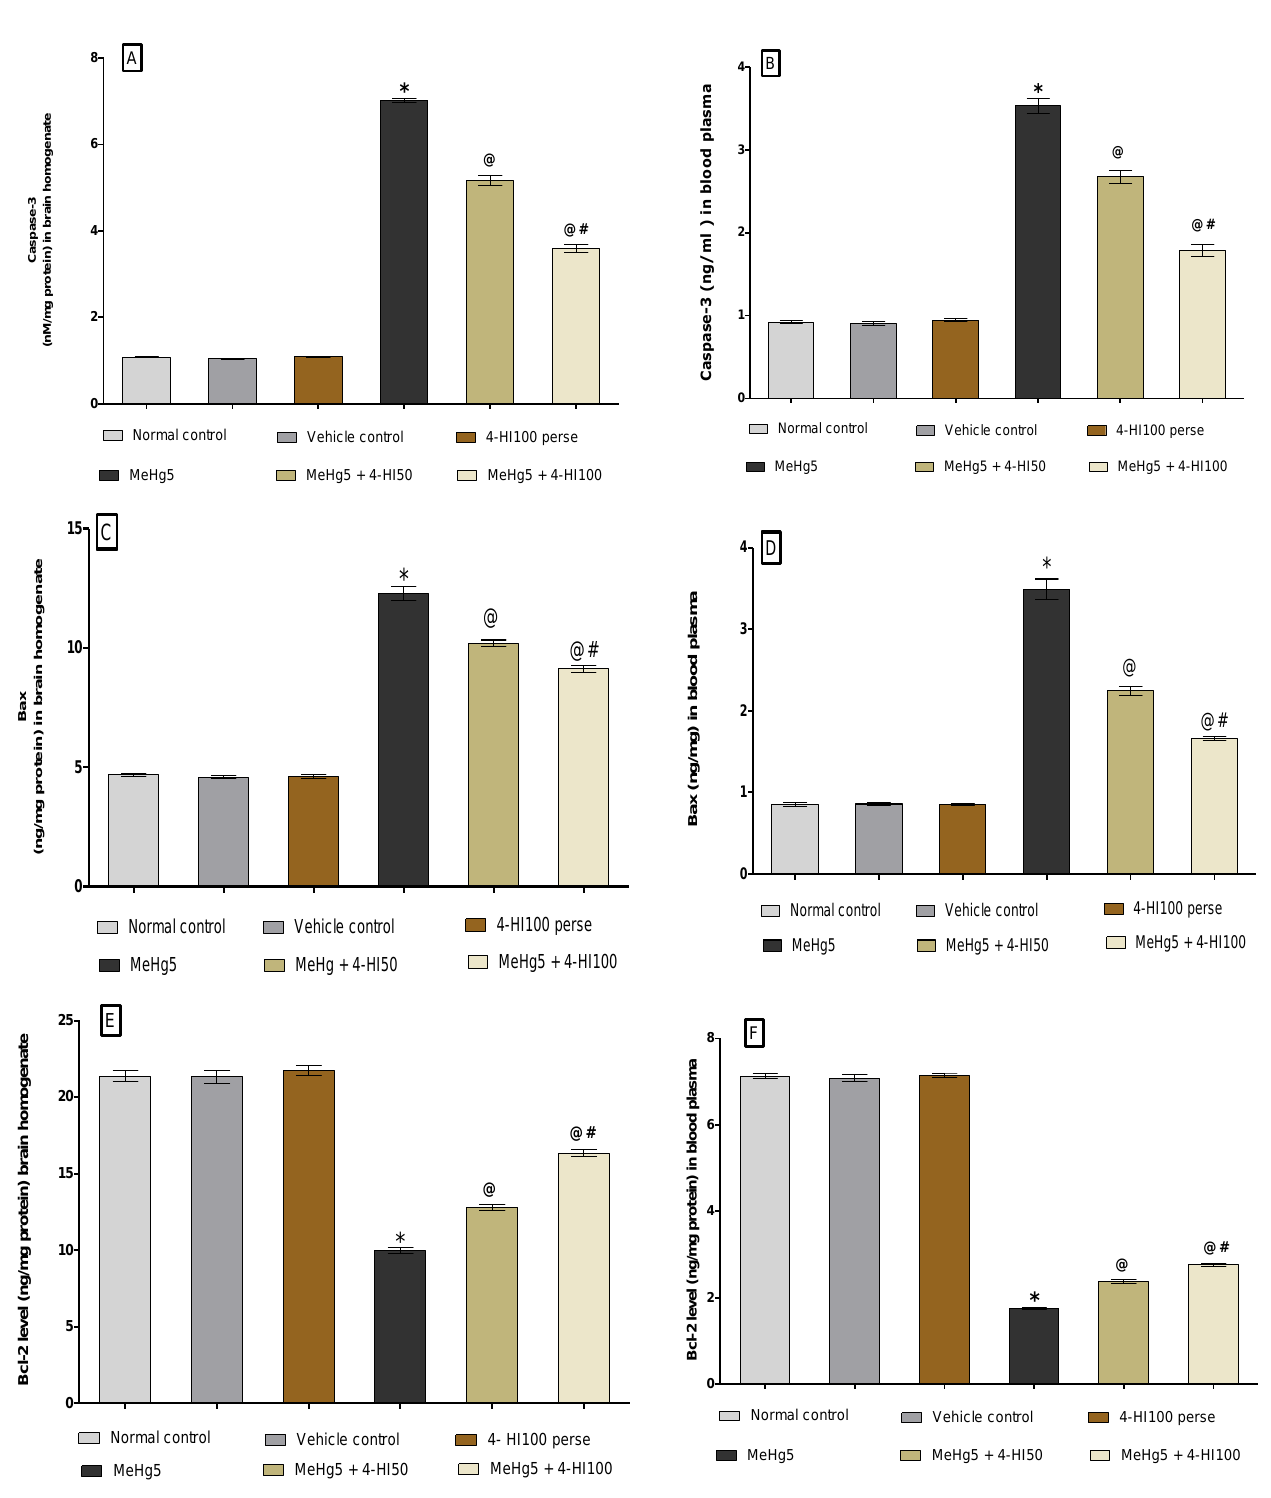
Figure 11. Effect of 4-hydroxyisoleucine on caspase-3, Bax and Bcl-2 levels after methyl mercury exposure in rats ( A – F ). Statistical analysis by one-way ANOVA (posthoc Tukey’s test). Values are expressed as mean ± SEM ( n = 6 rats per group). * p < 0.001 v/s normal control, vehicle control and 4-HI100 perse ; @ p < 0.001 v/s MeHg5; @# p < 0.001 v/s MeHg5 + 4-HI50. Likewise, continuous oral treatment with 4-HI at doses of 50 mg/kg and 100 mg/kg